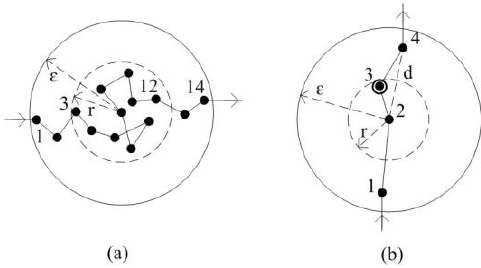
Figure 2. Two typical core sequences: (a) a core-sequence generated by continuously recording; and (b) a core-sequence caused by pausing recording.